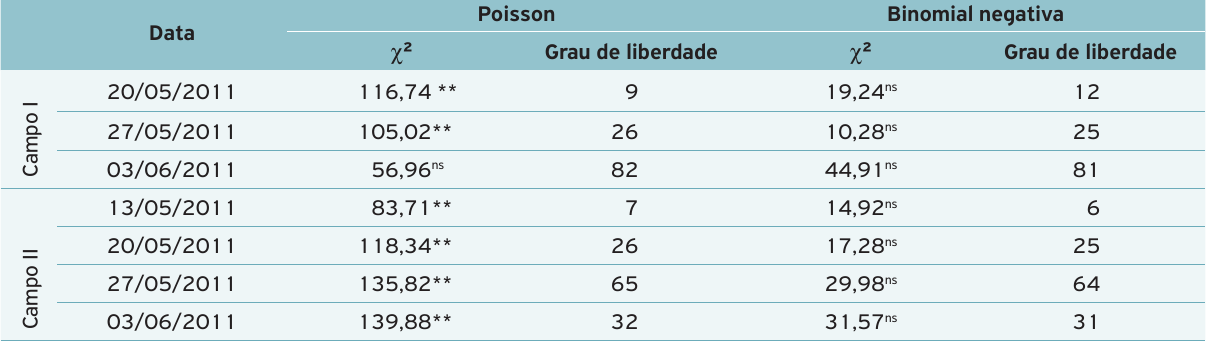
Tabela 2. Teste do qui-quadrado de aderência das frequências observadas e esperadas pelas distribuições de Poisson e binomial negativa para Empoasca kraemeri , em Vigna unguiculata (L.) Walp. Fortaleza, Ceará,